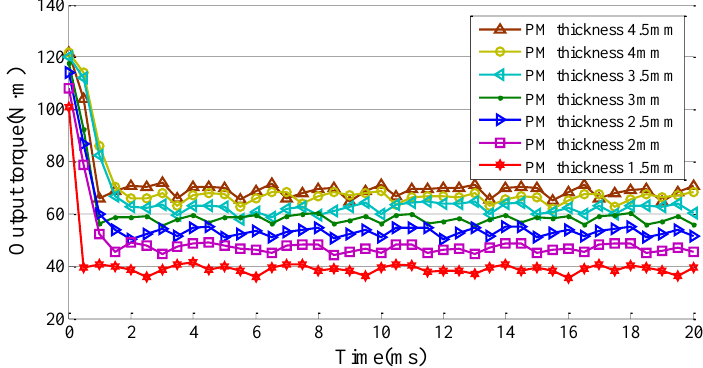
Figure 7. Output torque curves with different PM thickness l 4 .